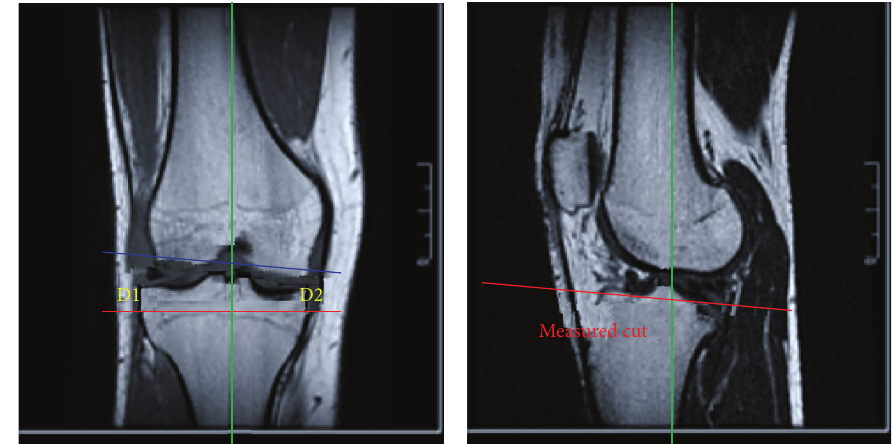
Figure 6: User interface.